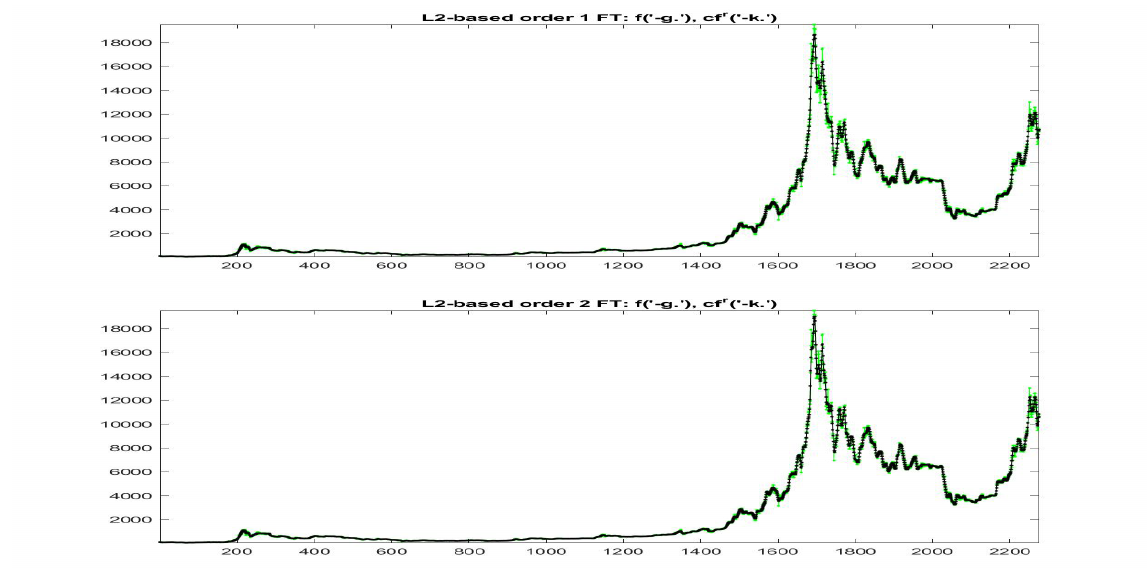
( t ) ( top : q = 1, bottom : q = 2) for Bitcoin j c , ( P a , A , r )